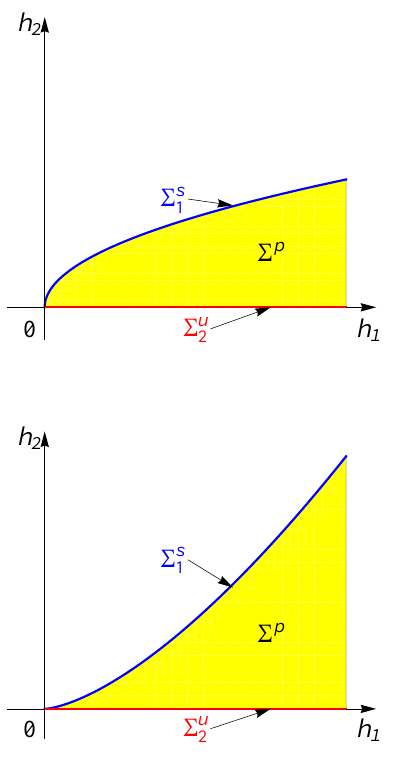
Figure 1. Image of the energy-Casimir mapping ( a + b + c < 1, a + b + c = 1, and a + b + c > 1